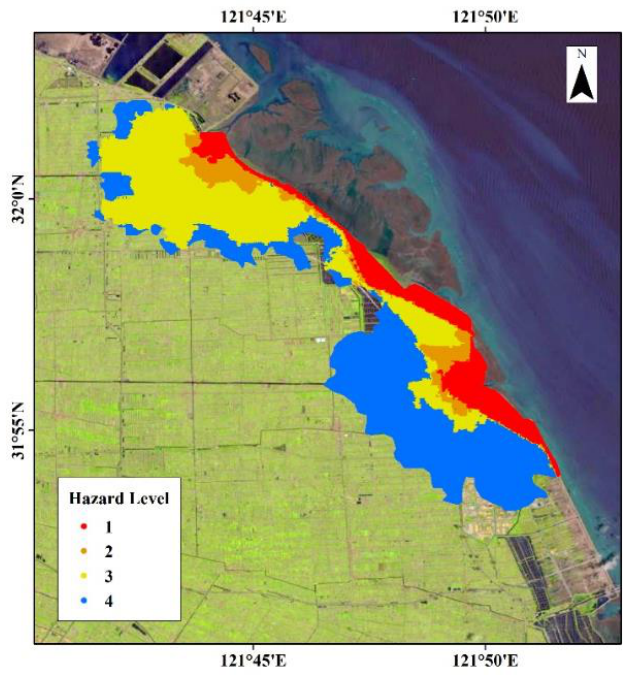
Figure 4. Tsunami hazard levels.